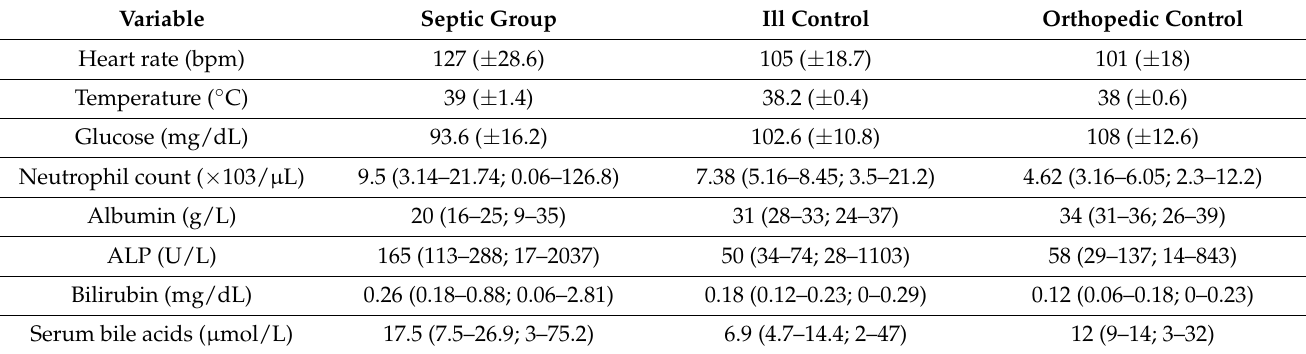
Table 1. Summary of results for septic, ill control, and orthopedic control groups. Values presented as mean ( ± SD) for normally distributed continuous variables and median (IQR; range) for non-normally distributed continuous